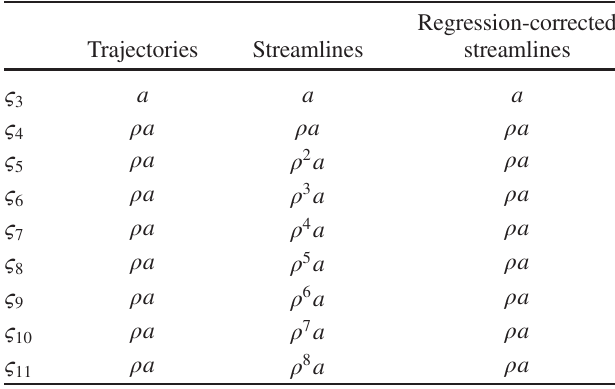
TABLE II. Comparison between the theoretical score sequen- ces within the trajectory, cohort streamline, and RC cohort streamline frameworks, assuming every pair of exams has the same correlation coefficient.